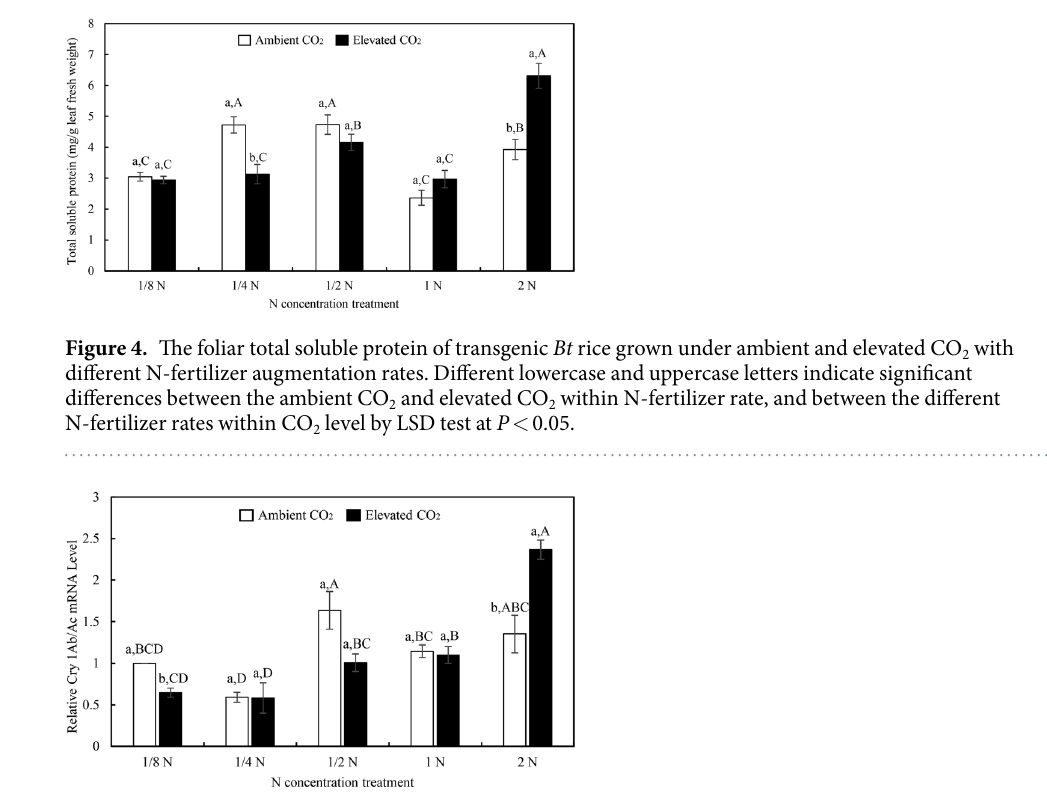
Figure 5. The relative transcript levels of fused Cry 1Ab/Ac gene in leaves of transgenic Bt rice grown under ambient and elevated CO 2 with different N-fertilizer rates. Different lowercase and uppercase letters indicate significant differences between the ambient CO 2 and elevated CO 2 within N-fertilizer rate, and between the different N-fertilizer rates within CO 2 level by LSD test at P <